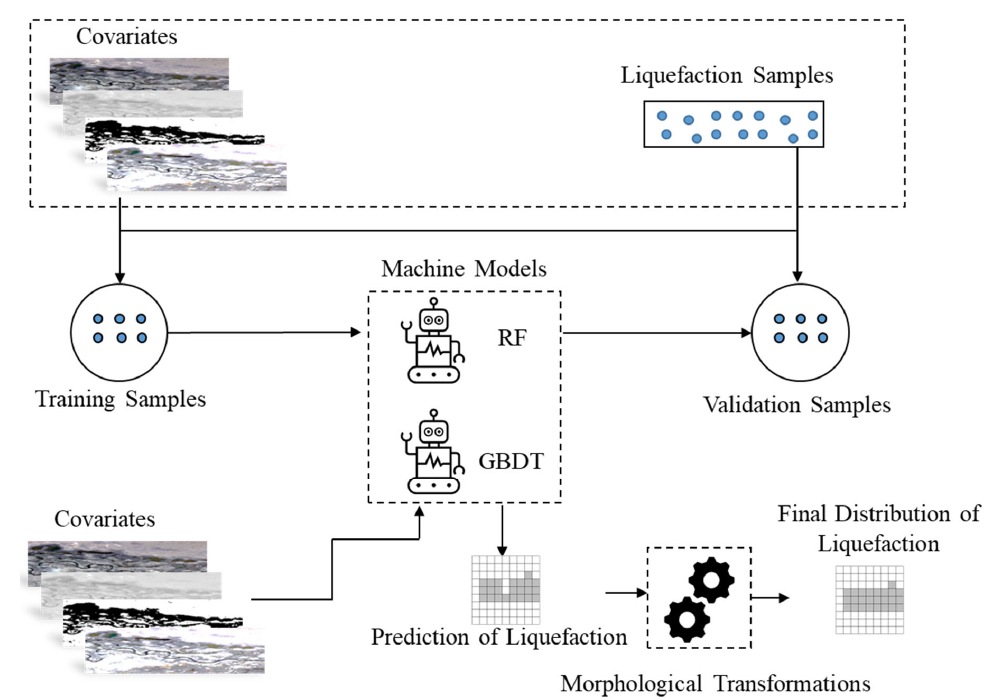
Figure 3. Flowchart of identifying the liquefaction in this study.